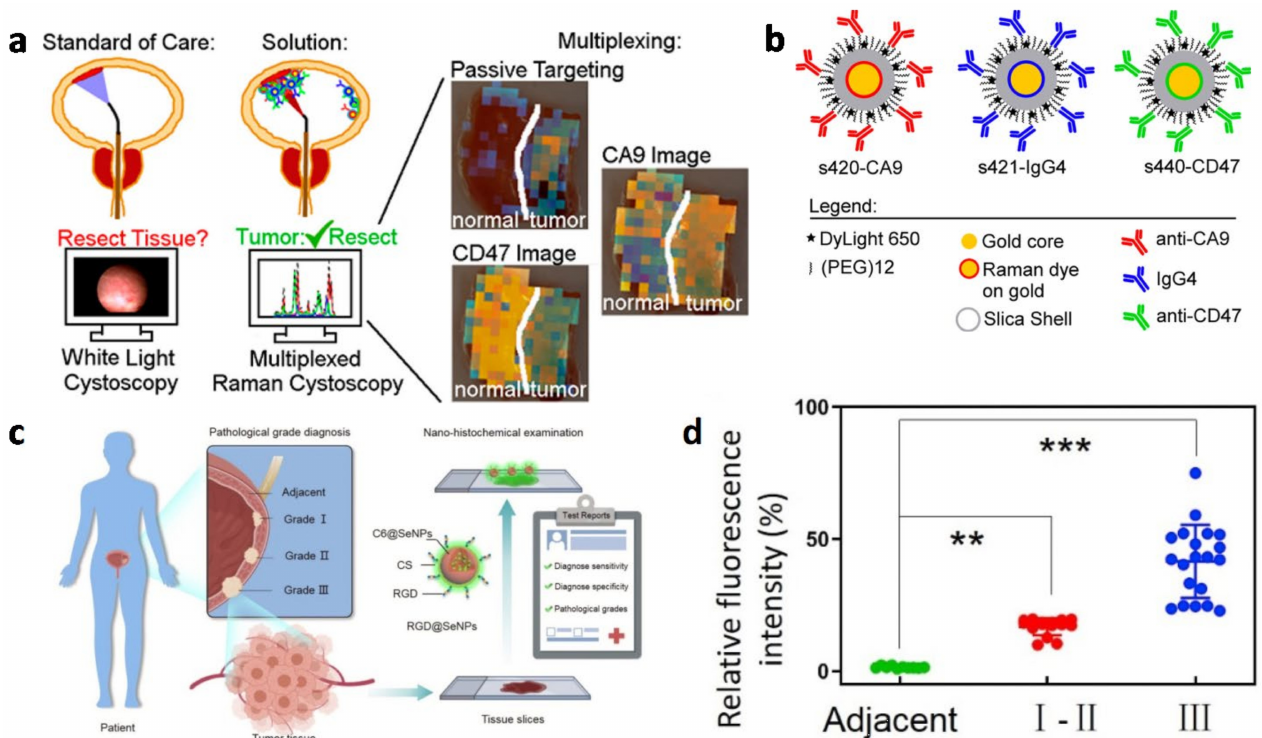
Figure 8. ( a ) Schematic of surface-enhanced Raman scattering nanoparticles (NPs) for the multiplexed imaging of BC tissue. ( b ) Schematic of SERS nanoparticles. (Reprinted with permission Ref. [73]. Copyright © 2018 American Chemical Society.) ( c ) Schematic illustration of the RGD polypeptide modified cancer-targeted selenium nano-system (RGD@SeNPs) for advanced nanohistochemical examination. ( d ) Statistical analysis of the diagnostic results with 100 µ M RGD@SeNPs nanoparticles, p < 0.01 (**) or p < 0.001 (***) (scale bar = 200 µ m). (Reprinted with permission Ref. [86]. Copyright